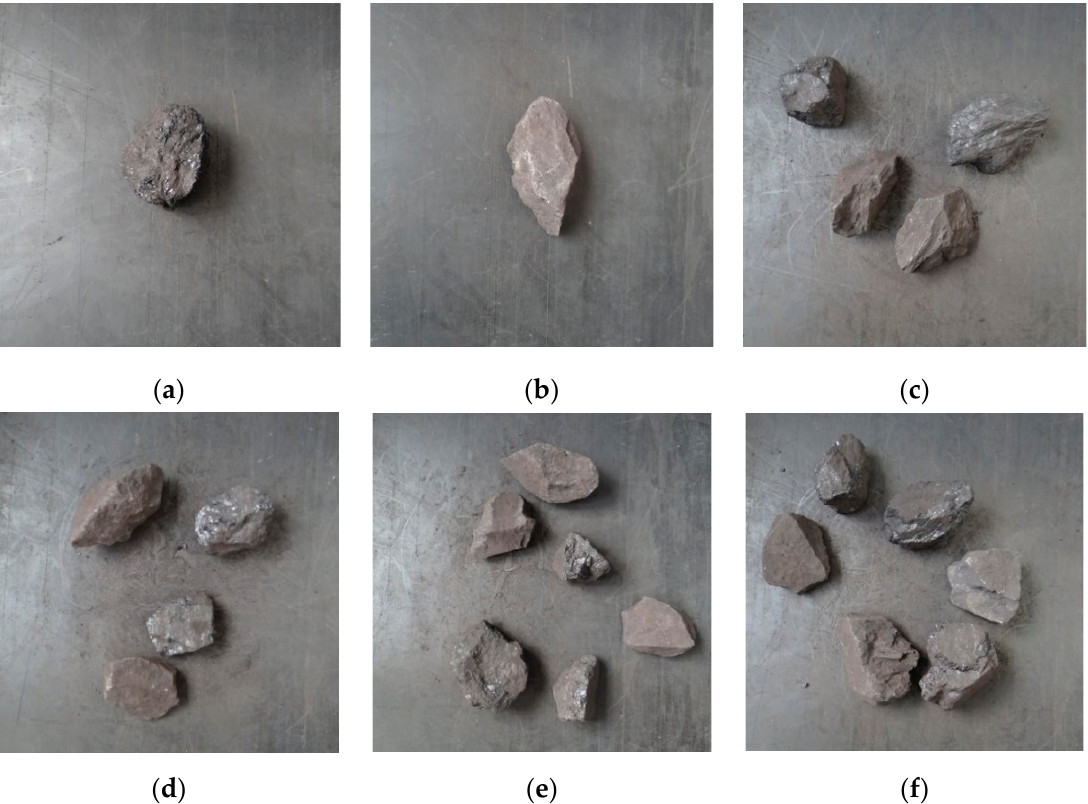
Figure 11. Some images of the coal gauge samples: ( a ) coal; ( b ) gangue; ( c – f ) several coal and gangue samples.